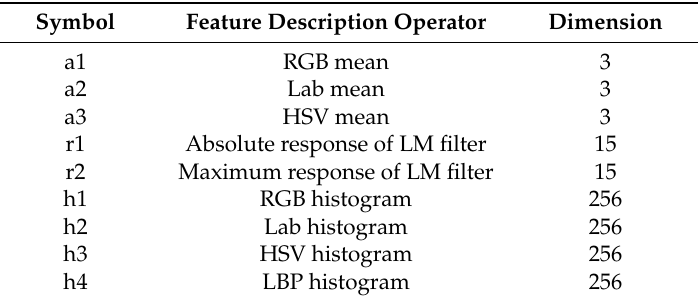
Table 1. Color and texture description